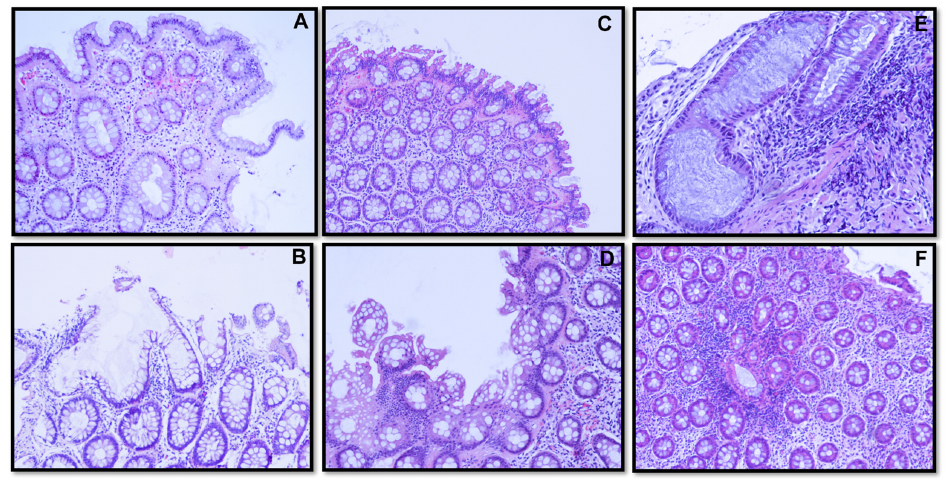
Figure 4. Photographs of histological sections showing ACF (H&E stain). Non-dysplasic distorted architecture (cells without morphological alterations) (( A , B ), ×100). Hyperplastic with “serrated” lumen, “sawtooth” appearance (( C , D ), ×100). Low-grade dysplasia with enlarged crypts, nuclear stratification, mucin depletion, elongated and hyperchromatic nuclei with loss of nuclear polarity and associated lymphocytic infiltrate (( E ), ×200; ( F ), ×100). ACF, aberrant crypt foci; H&E, hematox- ylin and eosin stain. Correlations between the intake of the major food groups, dietary bioactive compounds (fibres and polyphenols), and dietary xenobiotics with fecal mutagenicity are presented in Figure 5. Intake of whole grains, soft drinks, potatoes, and tubers, as well as fiber and B(a)P intake, showed an inverse association with mutagenicity levels (Figure 5a– c). In contrast, in the polyp group, PhIP, MeIQ, MeIQx, DiMeIQx, and total HA were positively associated with the mutagenicity (Figure 5c). Mutagenicity mean levels were